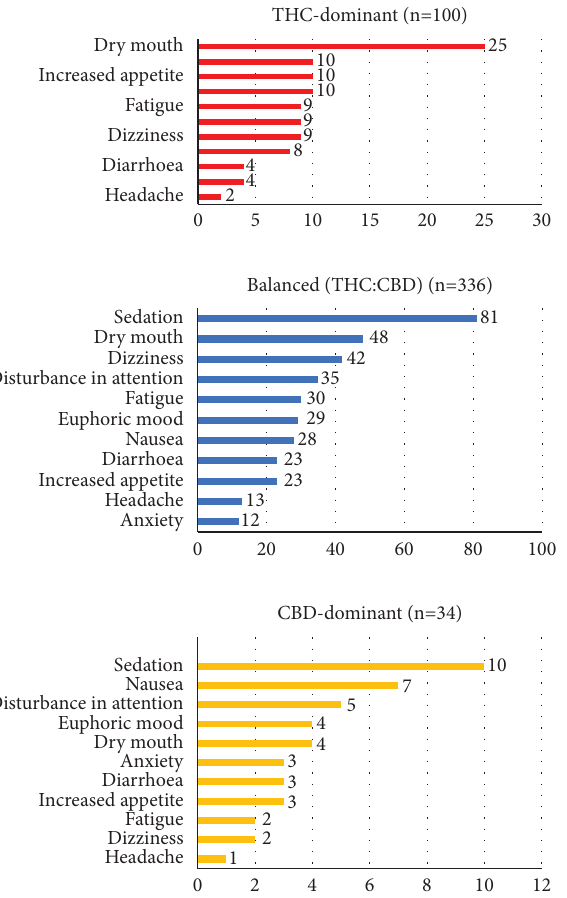
Figure 2: Distribution of most frequent nonserious AEs (PT level) per product